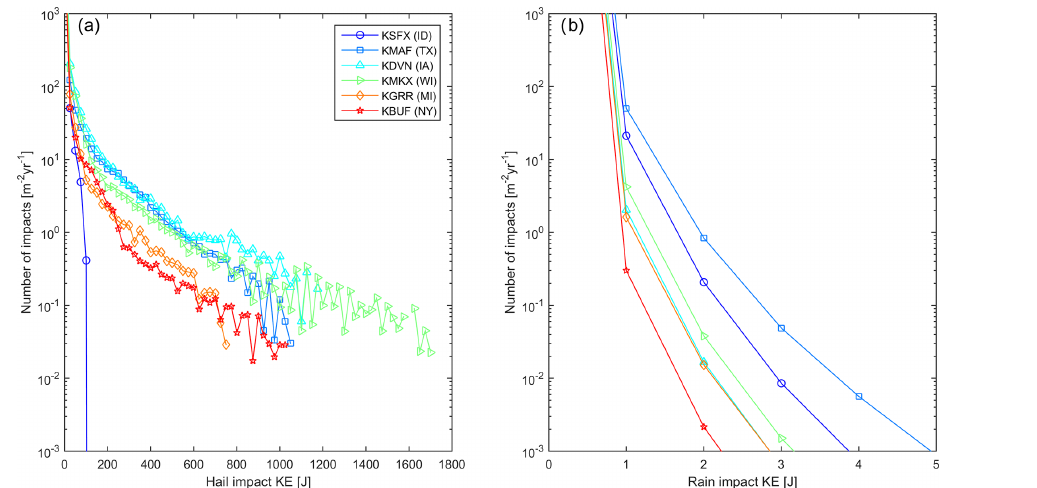
Figure 5. Histograms of kinetic energy of hydrometeor impacts. Annual number of (a) hail and (b) rain impacts per square meter of blade leading edge as a function of impact kinetic energy. The y axis in panel (b) has been truncated to a maximum value of 1000yr − 1 .